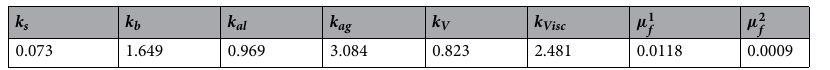
Table 7. The best values for the spring-network model parameters of the lung cancer cell.